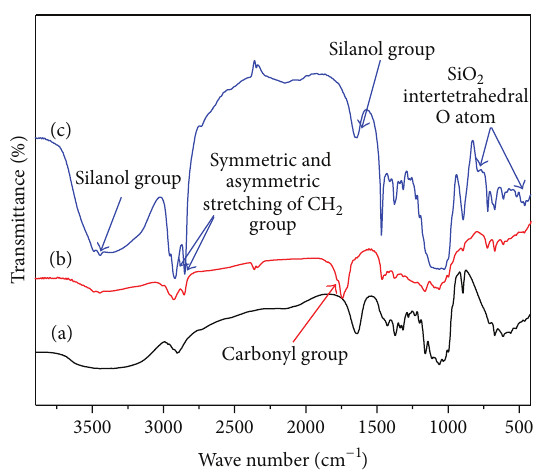
Figure 1: FTIR spectra of (a) CF, (b) Oil-g-CF, and (c)